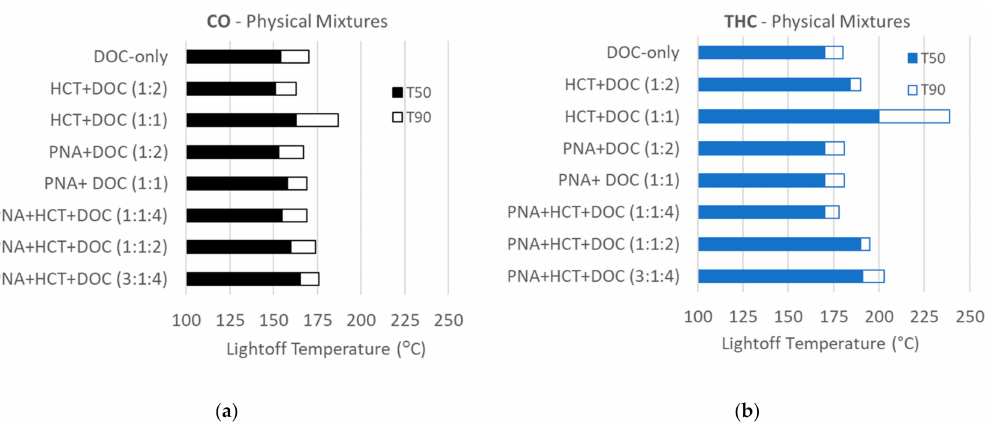
Figure 2. Inlet temperatures associated with 50% and 90% conversion (T50 and T90, respectively) for ( a ) CO and ( b ) THC over several multi-component physical mixture reactor beds. Ratios in parentheses represent the mass ratio of the different components in the sample,